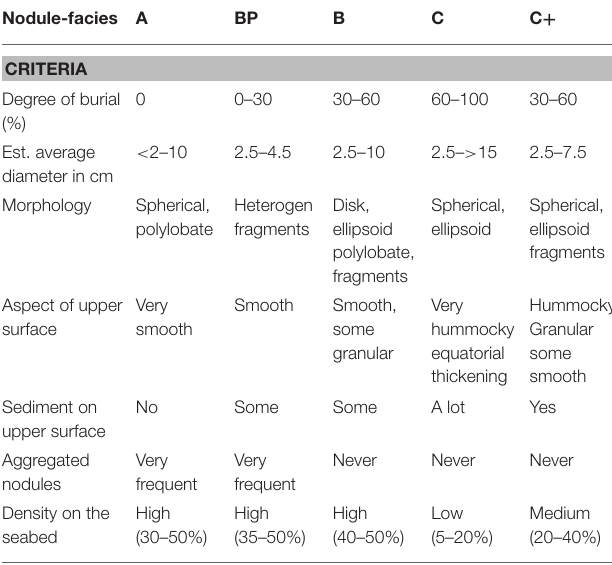
TABLE 1 | Nodules-facies classification based on visual identification from samples and imagery (Voisset and Hein, 1978; Hoffert and Saget, 2004). Nodule-facies A BP B C C +